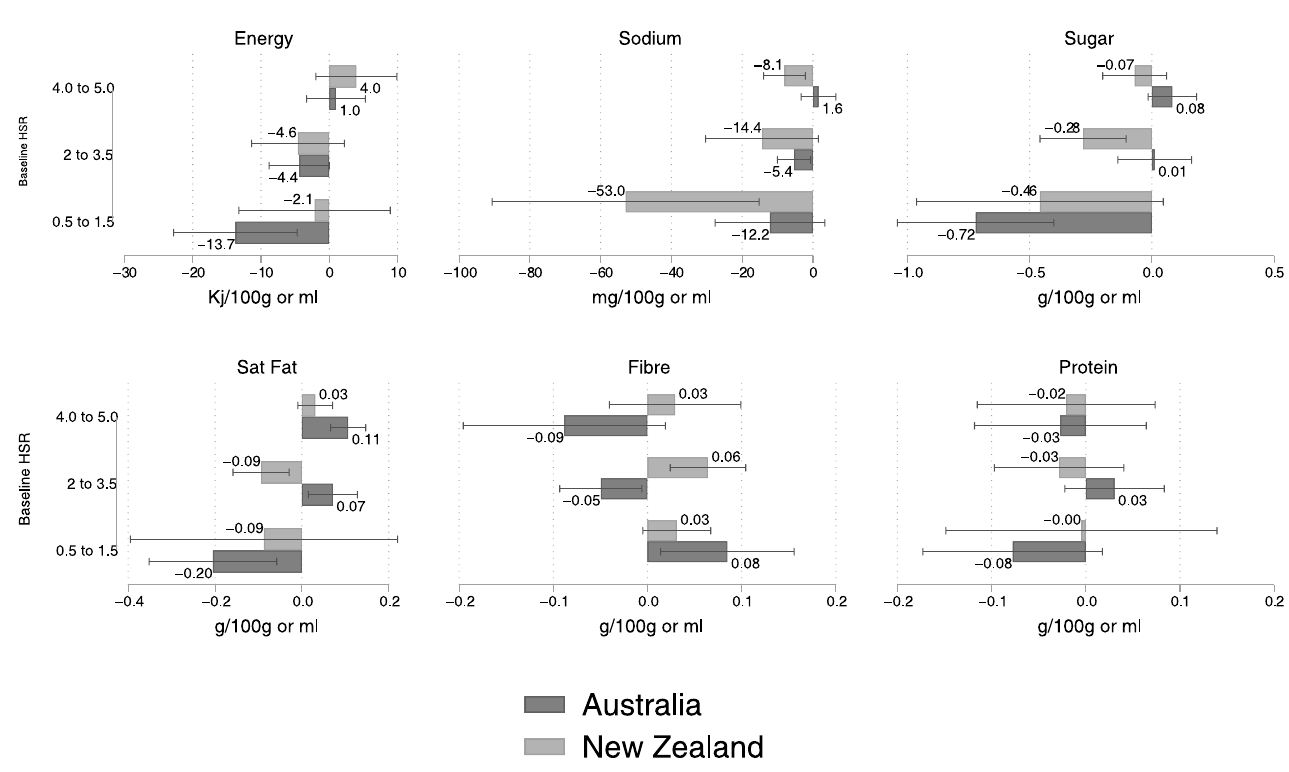
Fig 4. Stratified analyses on the 6 nutrient density outcomes by pretreatment HSR—4.0 to 5.0 (most nutritious), 2.0 to 3.5, and 0.5 to 1.5 (least nutritious). Regression estimates and 95% CIs displayed. Data used to construct this figure are in S3 Text. CI, confidence interval; HSR, Health Star Rating.